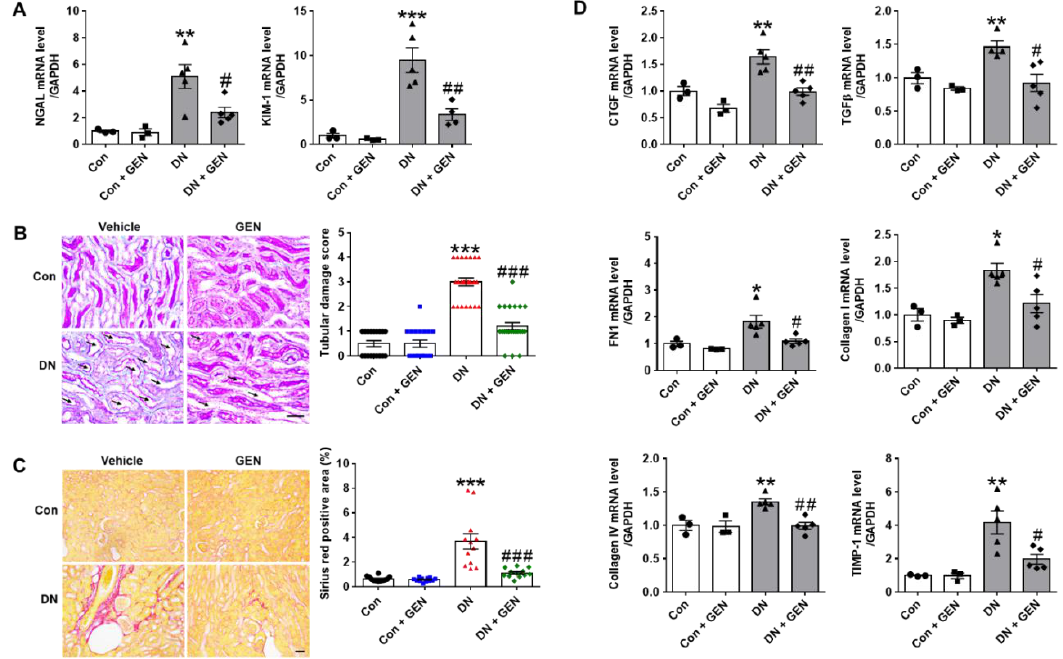
Figure 2. Geniposide reduces renal tubular injury and interstitial fibrosis in DN. ( A ) Relative mRNA levels of kidney injury molecule-1 (KIM-1) and neutrophil gelatinase-associated lipocalin (NGAL), specific biomarkers for renal tubular injury, were assessed by real-time PCR analysis ( n = 3–5). ( B ) Renal tubular injury was also analyzed by PAS staining, the representative images were shown, and the tubular damage scores were evaluated (black arrows indicate damaged tubules), ( n = 3–5). ( C ) Kidney sections were processed for Picro-Sirius Red staining and fibrotic area was presented as stained areas in percentages (%) using ImageJ software ( n = 3–5). ( D ) Relative mRNA levels of fibrogenic genes were determined by real-time PCR analysis. Relative mRNA expression was normalized to that of GAPDH ( n = 3–5). Data are presented as the mean ± SEM. One-way ANOVA was used for statistical analysis followed by Bonferroni’s multiple comparisons. * p < 0.05, ** p < 0.01, *** p < 0.001 vs. control mice; and # p < 0.05, ## p < 0.01, ### p < 0.001 vs. DN mice. Scale bar, 50 µm.